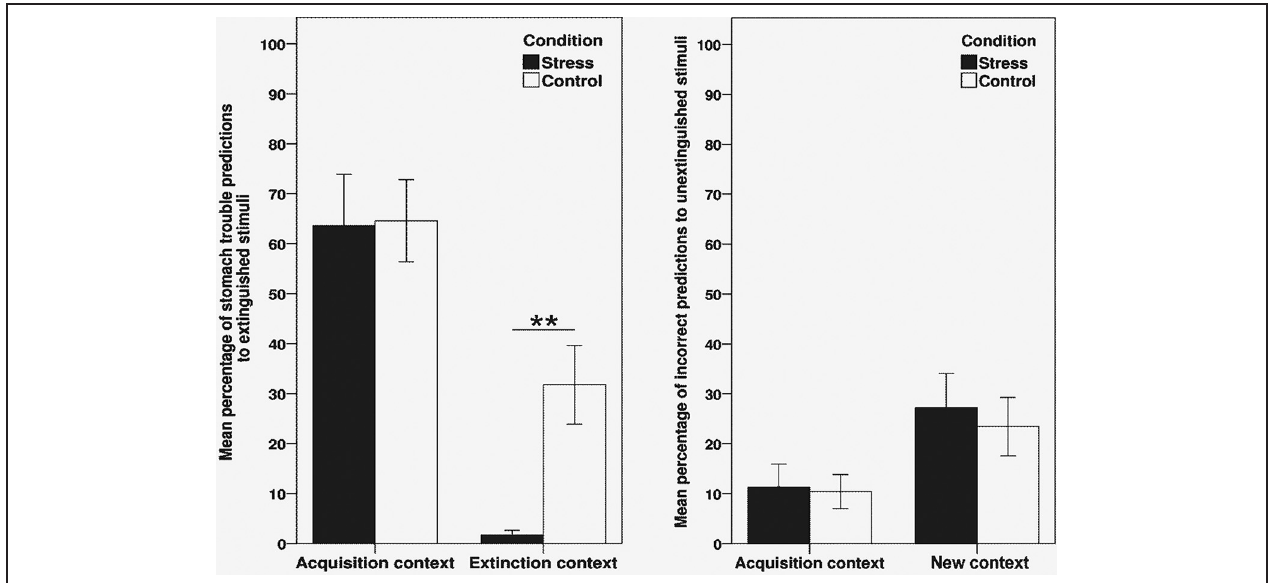
acquisition context trials and extinction context trials (stimuli a/b + ) or new context trials, respectively (stimuli e + /g − ), and is averaged over all four trials of the renewal test. ** Significant difference between stress and control group, p < .001 ( t -test). Error bars denote standard errors of the mean.